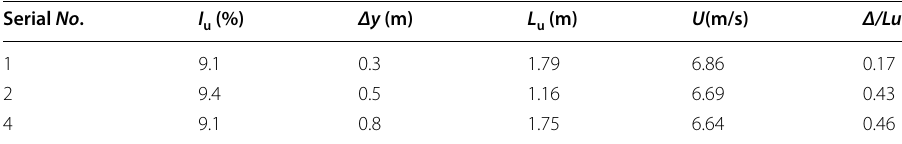
Table 2 Parameters of wind field Serial No